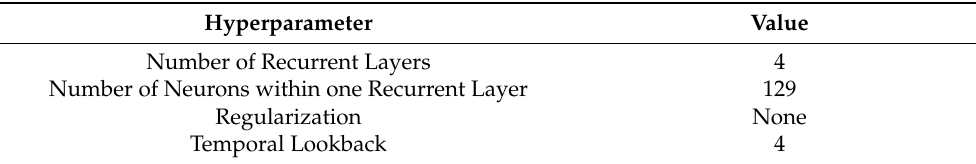
Table 2. Artificial Neural Network—Hyperparameters. Hyperparameter Value Number of Recurrent Layers 4 Number of Neurons within one Recurrent Layer 129 Regularization None Temporal Lookback